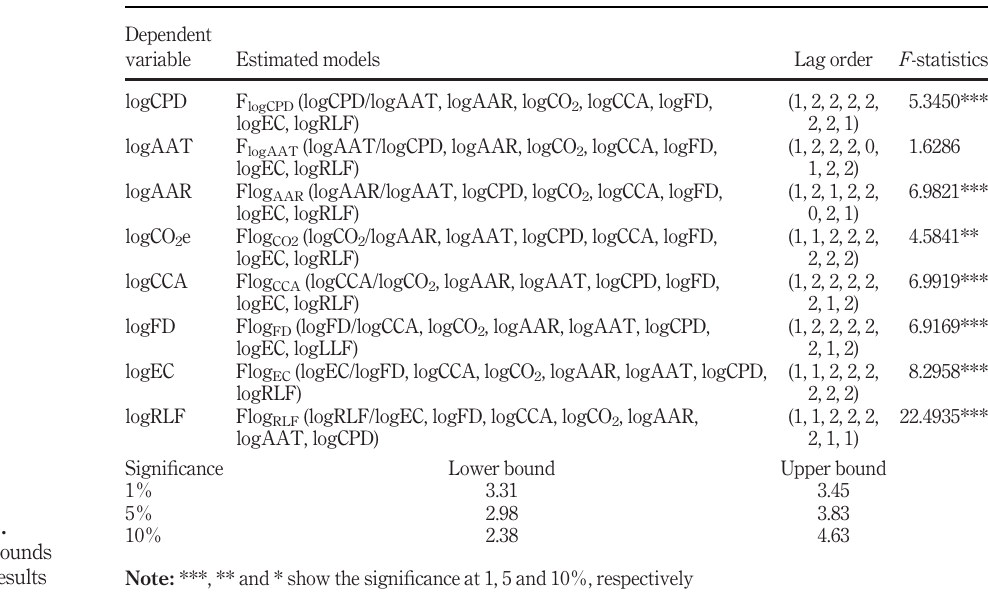
Table 2. ARDL-Bounds testing results